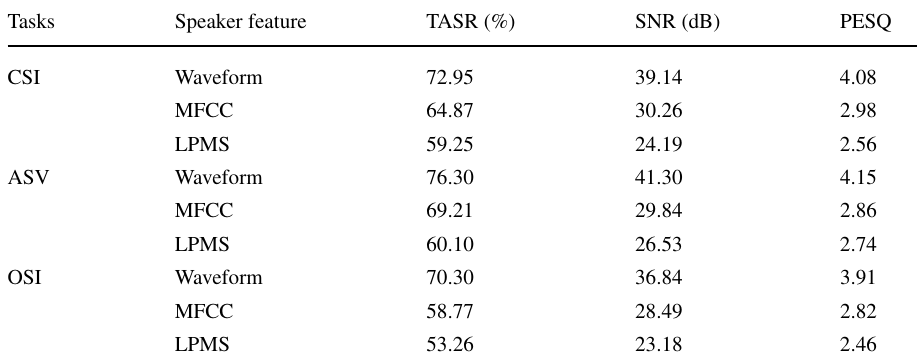
Table 11 The performance of the attacks using different speaker features on